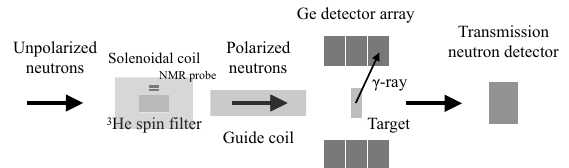
Figure 1. A schematic view of the experimental setup at BL04.